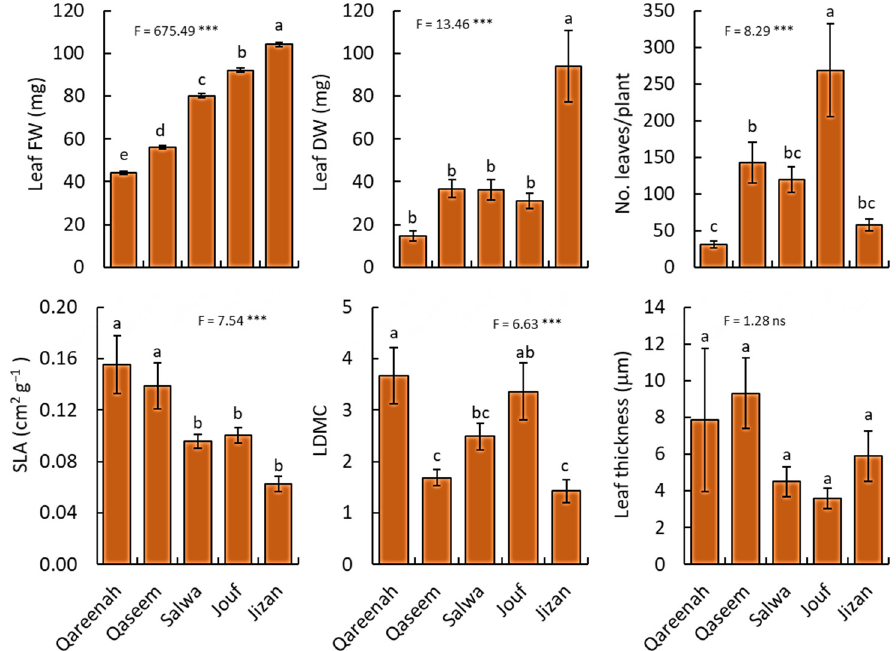
Figure 4. Comparison of leaf traits for Aeluropus lagopoides growing in different saline flat regions of Saudi Arabia. Values are average ( n = 10 ), and the bar represents standard error. Different letters among regions showed significant differences at p < 0.05 after Duncan’s test. SLA: specific leaf area, LDMC: leaf dry matter content. FW: fresh weight, DW: dry weight. *** p < 0.001, and “ns” for p >